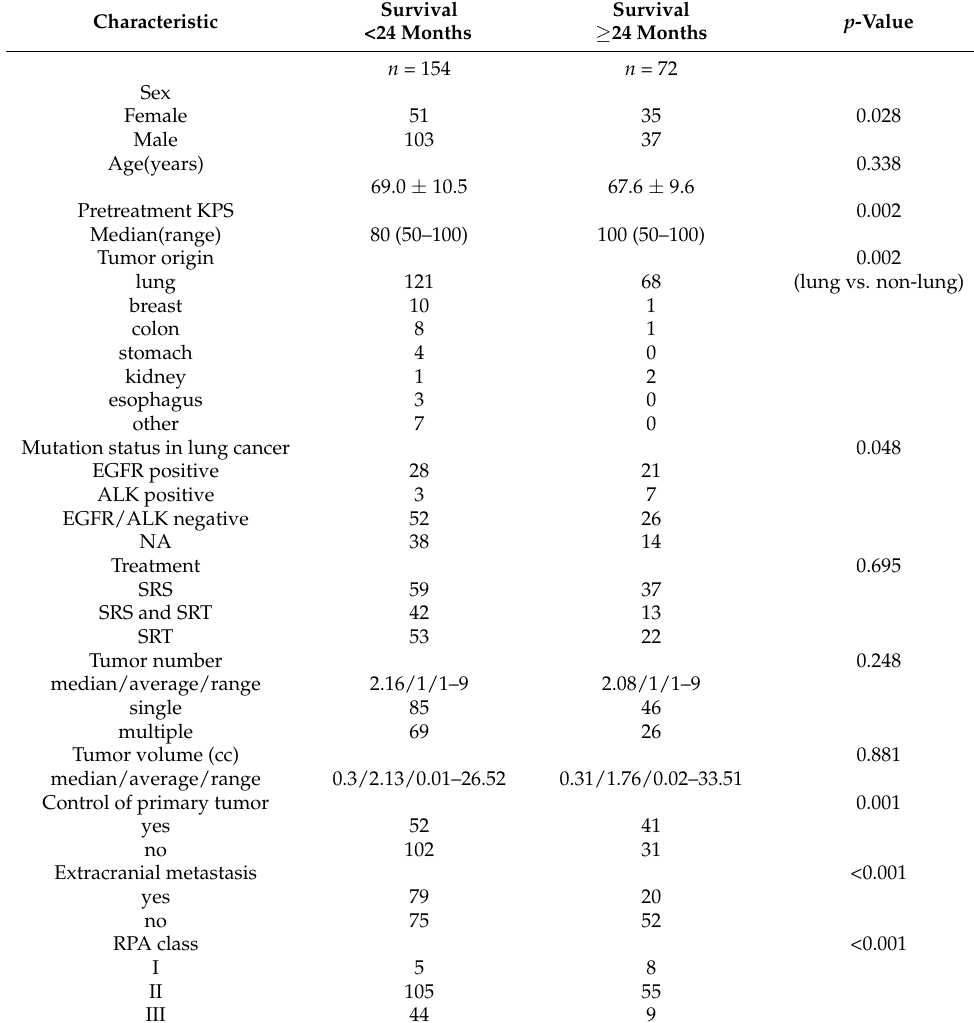
EGFR: epidermal growth factor recptor, ALK: anaplastic lymphoma kinase, NA: not